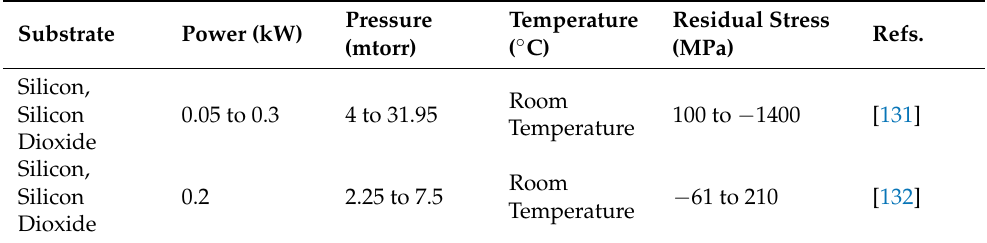
Table 15. Residual Stresses of Sputter-Deposited Silicon Carbide Layers for Various Processing Conditions. All Depositions were performed at Room